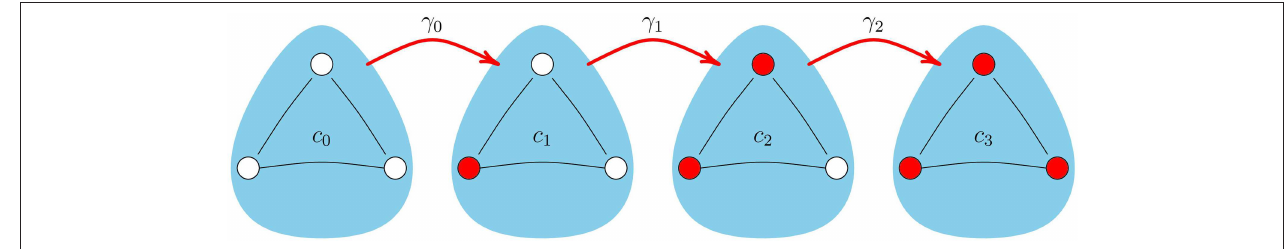
n ( n i ) c i . i 0 − = P